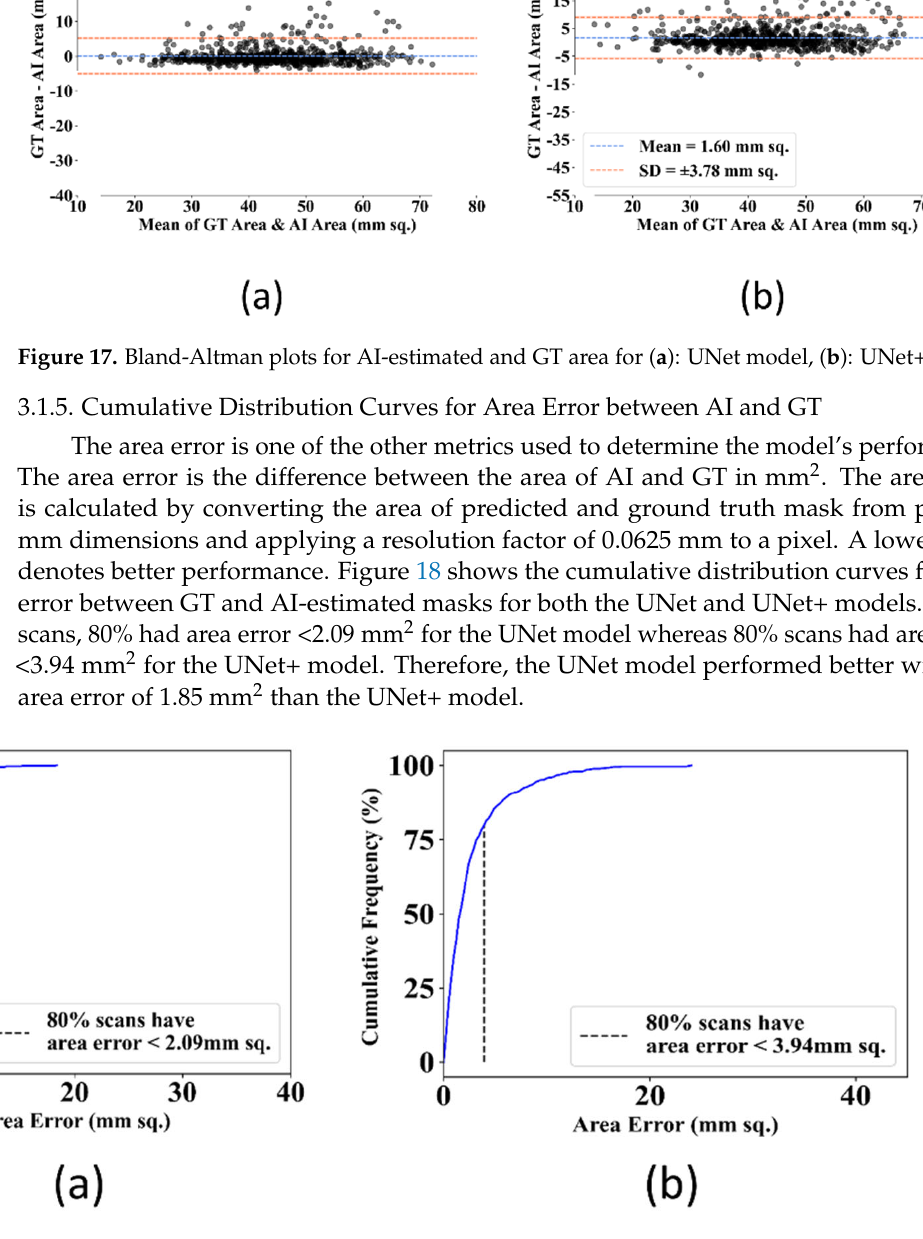
15 of 34 Figure 15. AUC and ROC Curves for ( a ): UNet model, ( b ): UNet+ model ( p < 0.0001). 3.1.3. Correlation Analysis between AI and GT The regression curve is a prevailing method to find a correlation between two measures. The Correlation coefficient (CC) signifies the relationship between the two measures. The higher CC value denotes a better model performance. Figure 16 shows the CC between AI ‐ estimated and GT area for both models, i.e., UNet and UNet+. The CC value for the UNet model was 0.97, whereas the CC value for the UNet+ model was 0.93. The UNet model showed better performance by 0.04 CC than the UNet+ model. Figure 16. CC for GT and AI ‐ estimated area for ( a ): UNet model, ( b ): UNet+ model. 3.1.4. Bland–Altman Plot for AI and GT Area The Bland–Altman plot denotes the difference between the AI and GT areas along the y ‐ axis and the mean of AI and GT areas along the x ‐ axis. The less the mean and SD (standard deviation) values show, the better the performance. Figure 17 shows the Bland–